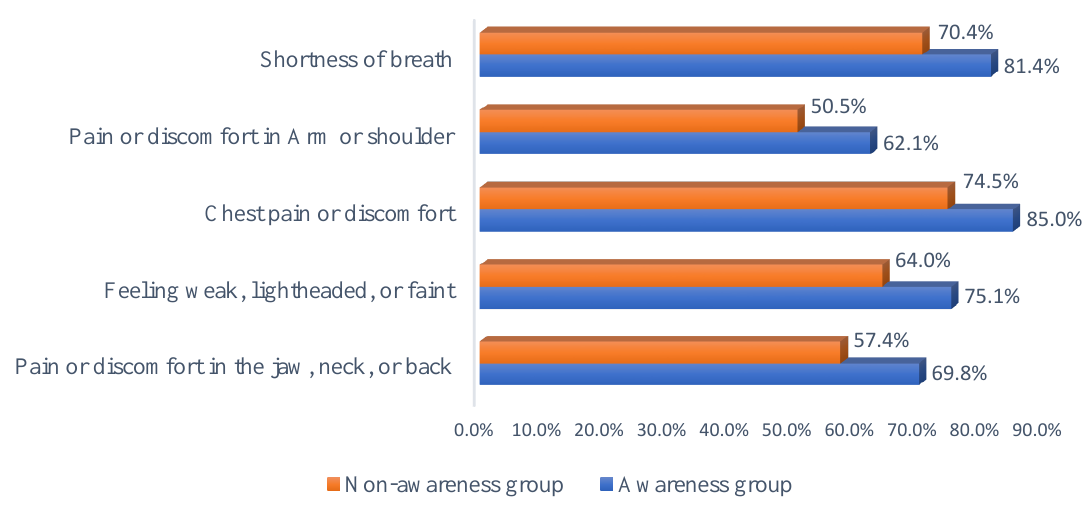
Factors associated with KCVDs warning signs are listed in Table 3. Among women with HTN, more BP level awareness was associated with better KCVDs (OR = 1.121, p < 0.001). Middle-age (OR = 1.046, p = 0.008), employment (OR = 1.034, p = 0.017), and married and living with a spouse (OR = 1.068, p < 0.001) were associated with better KCVDs. In addition, lower levels of education (OR = 0.931, p < 0.001) and regular walking (OR = 0.964, p = 0.015) were associated with lower KCVDs.